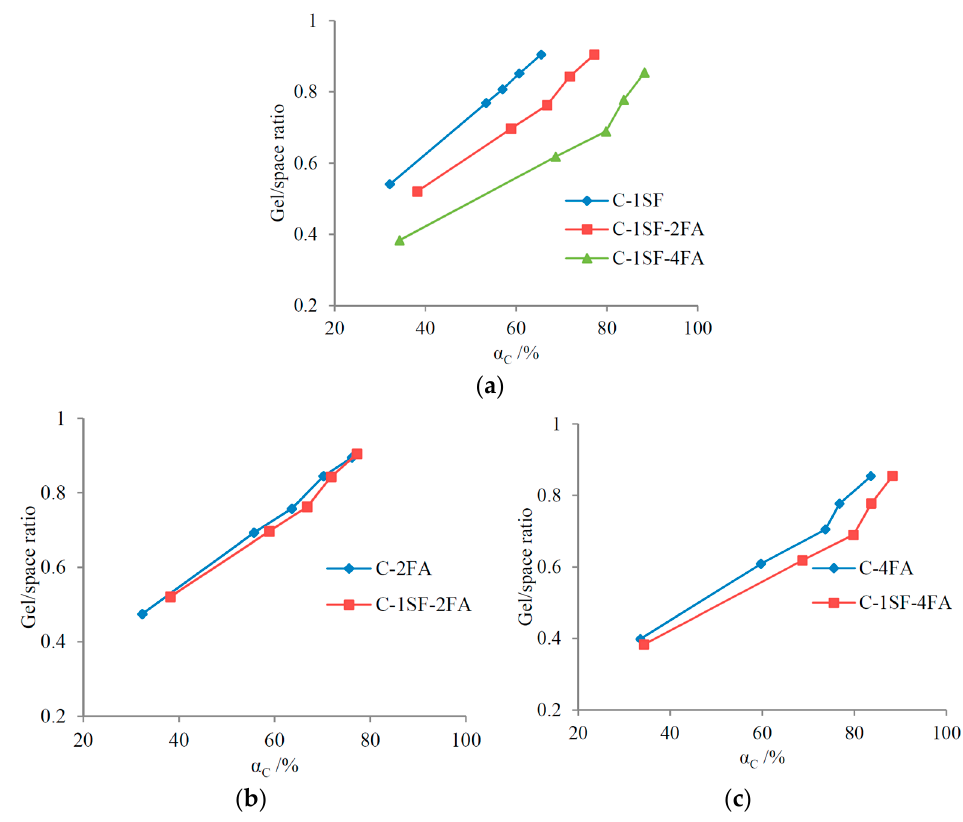
Figure 11. Relation between gel/space ratio and cement reaction degree in the C-SF-FA system: ( a ) FA replacement, when m SF = 10%; ( b ) SF replacement, when m FA = 20%; and ( c ) SF replacement, when (cid:1865) (cid:3007)(cid:3002) = 40%.